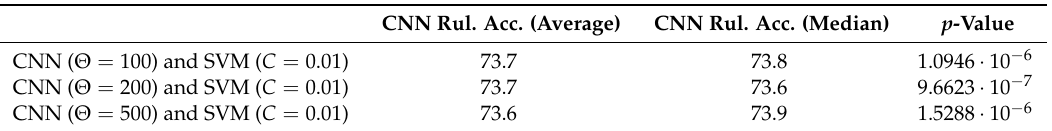
Table 7. ANOVA comparison between CNNs and SVMs providing the better average predictive accuracy (equal to 70.6%).